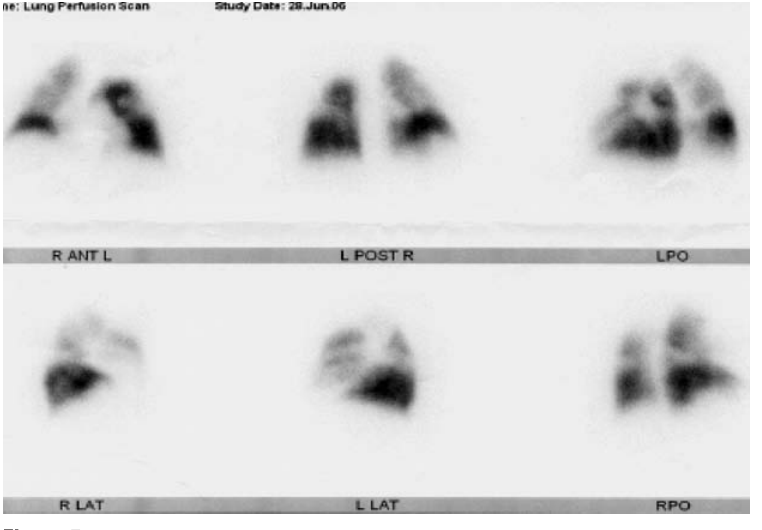
Scintigraphy in a patient with thromboembolic pulmonary hypertension. The lung perfusionscan reveals segmental, large and bilateral defects. The ventilation phase (not shown) was normal.